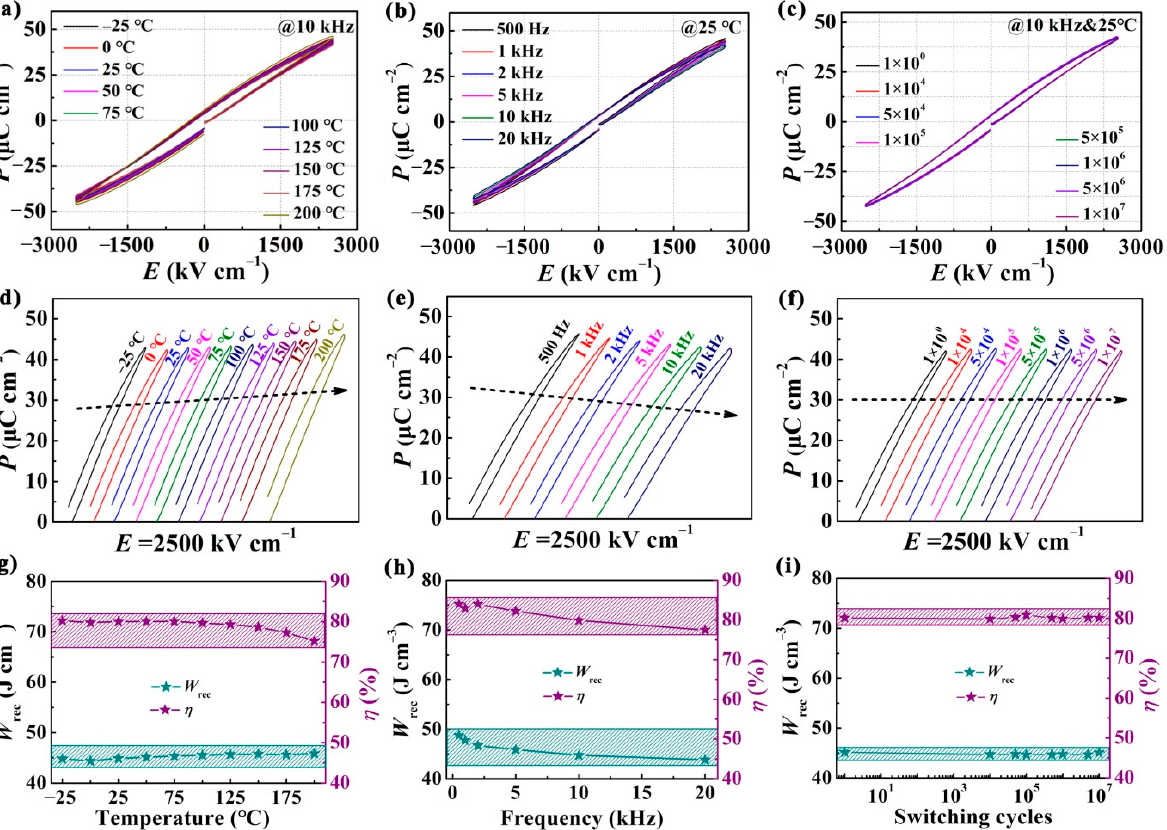
Figure 6. CBTi-BFO thin film annealed at 500 °C: ( a – c ) bipolar P-E hysteresis loops measured at different temperatures/frequencies/switching cycles; ( d – f ) unipolar P-E hysteresis loops of CBTi-BFO films at different temperatures/frequencies/switching cycles; ( g – i ) the changes of W rec and η depending on temperature/frequencies/switching cycles.